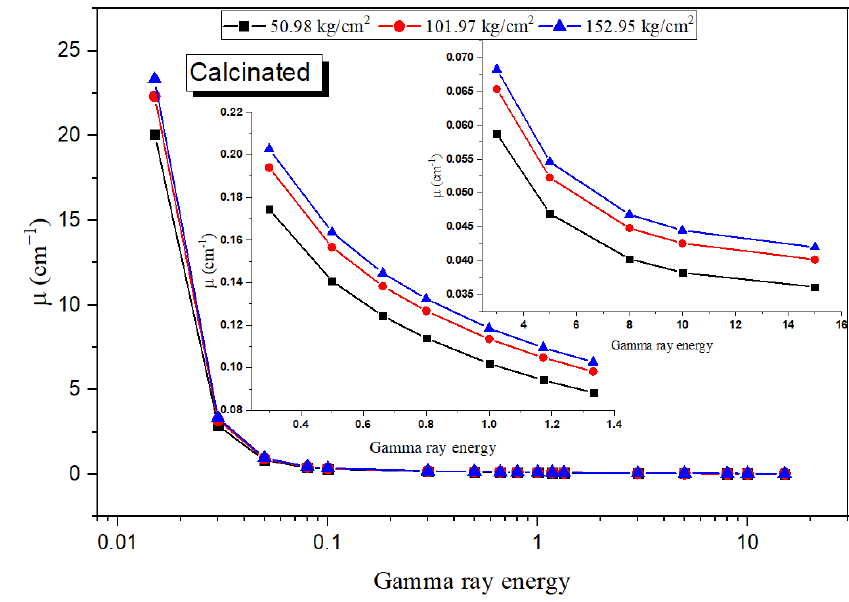
Figure 6. The LAC for calcinated bentonite at various gamma-ray energies.